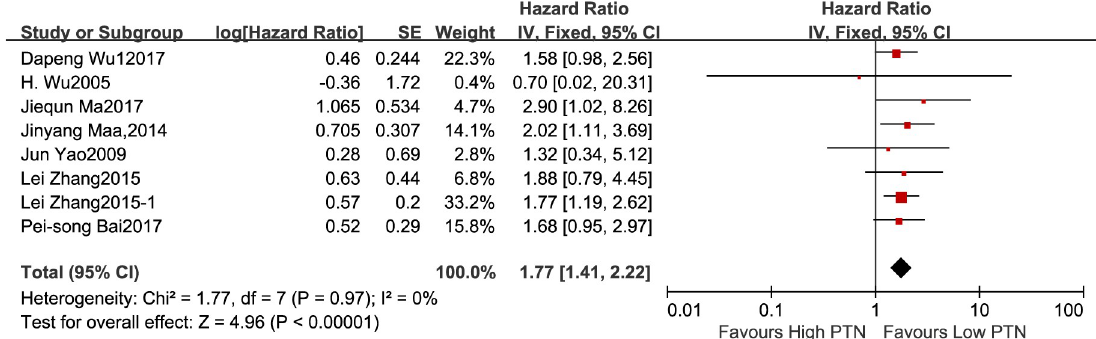
Fig 7. A forest plot for the association between the PTN expression levels with OS. The analysis indicated a poor prognosis in the high PTN expression group.